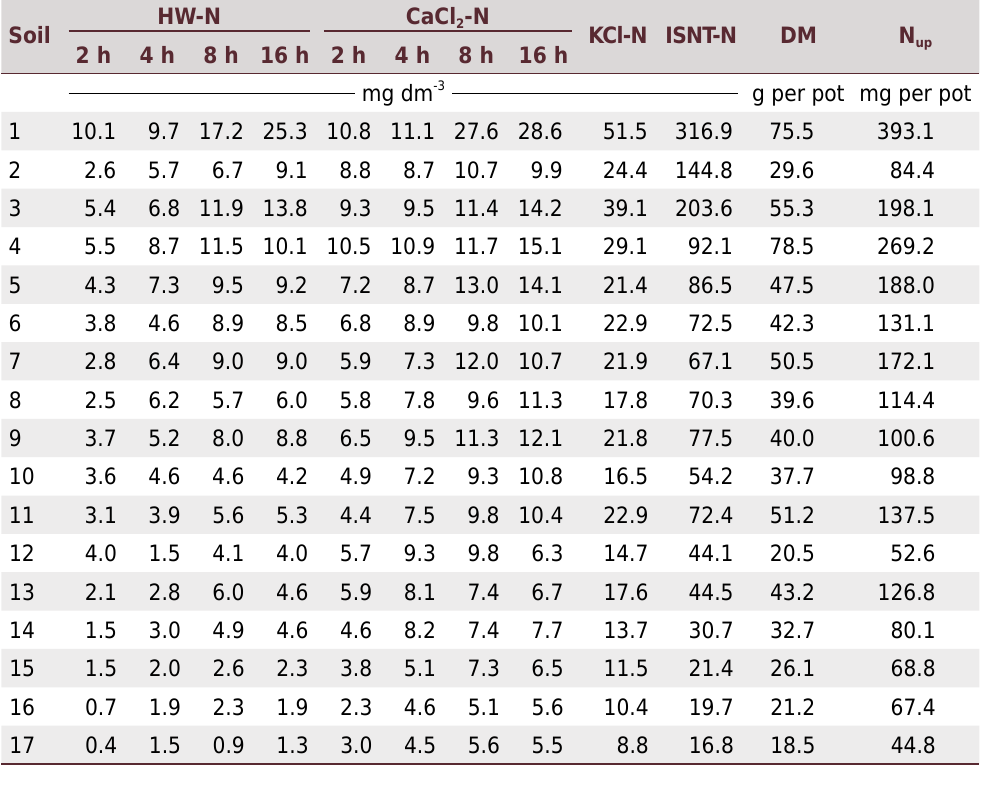
Table 2. Potentially available N concentrations in 17 soil samples subjected to organic N extraction using hot water (HW-N), hot solutions of 0.01 mol L -1 CaCl 2 (CaCl 2 -N) and 2 mol L -1 KCl (KCl-N) under increasing heating periods, and the Illinois Soil Nitrogen Test (ISNT-N); corn plant dry matter production per pot (DM) and N uptake per pot (N up ) obtained in a greenhouse experiment with the same soil samples Soil